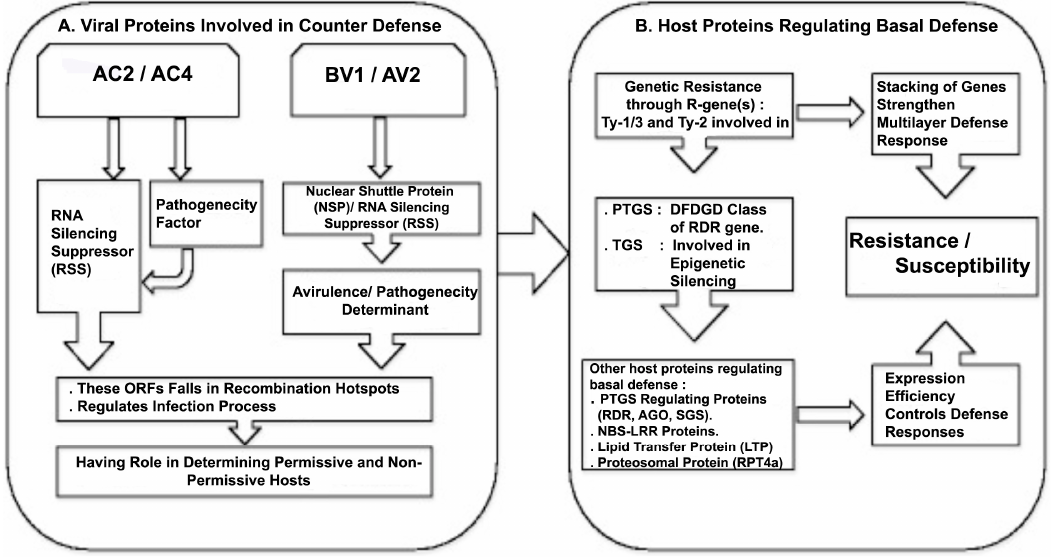
Figure 1. Schematic presentation of cascade of events representing host plant basal defense responses and viral protein-derived counter defense reactions. ( A ) Viral proteins involved in counter defense. AC2 and AC4 are two open reading frames (ORFs) present on the negative strand of DNA-A, coding for proteins with role in RNA-silencing suppression and determination of pathogenicity. BV1 and AV2 ORFs present on the sense strands of DNA-B and DNA-A, respectively, coding for the nuclear shuttle protein (NSP) and an RNA silencing suppressor (RSS), and are characterized as avirulence/pathogenicity determinants. Recombination analysis by Fortes et al. [7] shows that AC2, AC4 and AV1 fall into recombination hotspots, suggesting their fast evolution to counter-defense mechanisms of new hosts; ( B ) host plant proteins regulating basal defense. Functional characterization of genetic resistance based on Ty -like genes in tomato suggests their role in regulation of transcriptional and post-transcriptional gene silencing (TGS and PTGS, respectively), stacking of these loci contributes to multilayer defense response. Other basal defense genes induced during infection fall into PTGS-controlling proteins, nucleotide-binding site leucine-rich repeat (NBS-LRR) proteins, a lipid transfer protein (LTP) and the protein of the proteosomal complex. Their relative expression efficiency determines resistance/susceptibility.